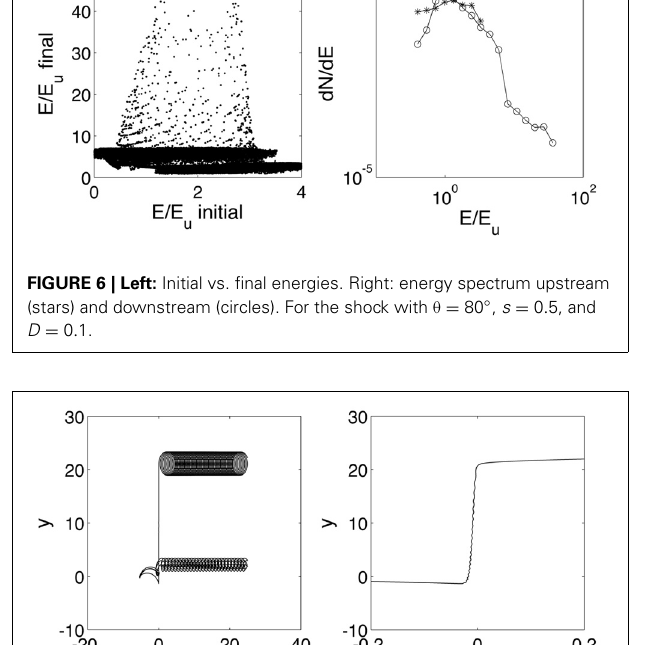
FIGURE 4 | Magnetic field magnitude calculated from the pressure balance condition with the ion distribution obtained numerically for θ = 70 ◦ . Other parameters remain the same as above.